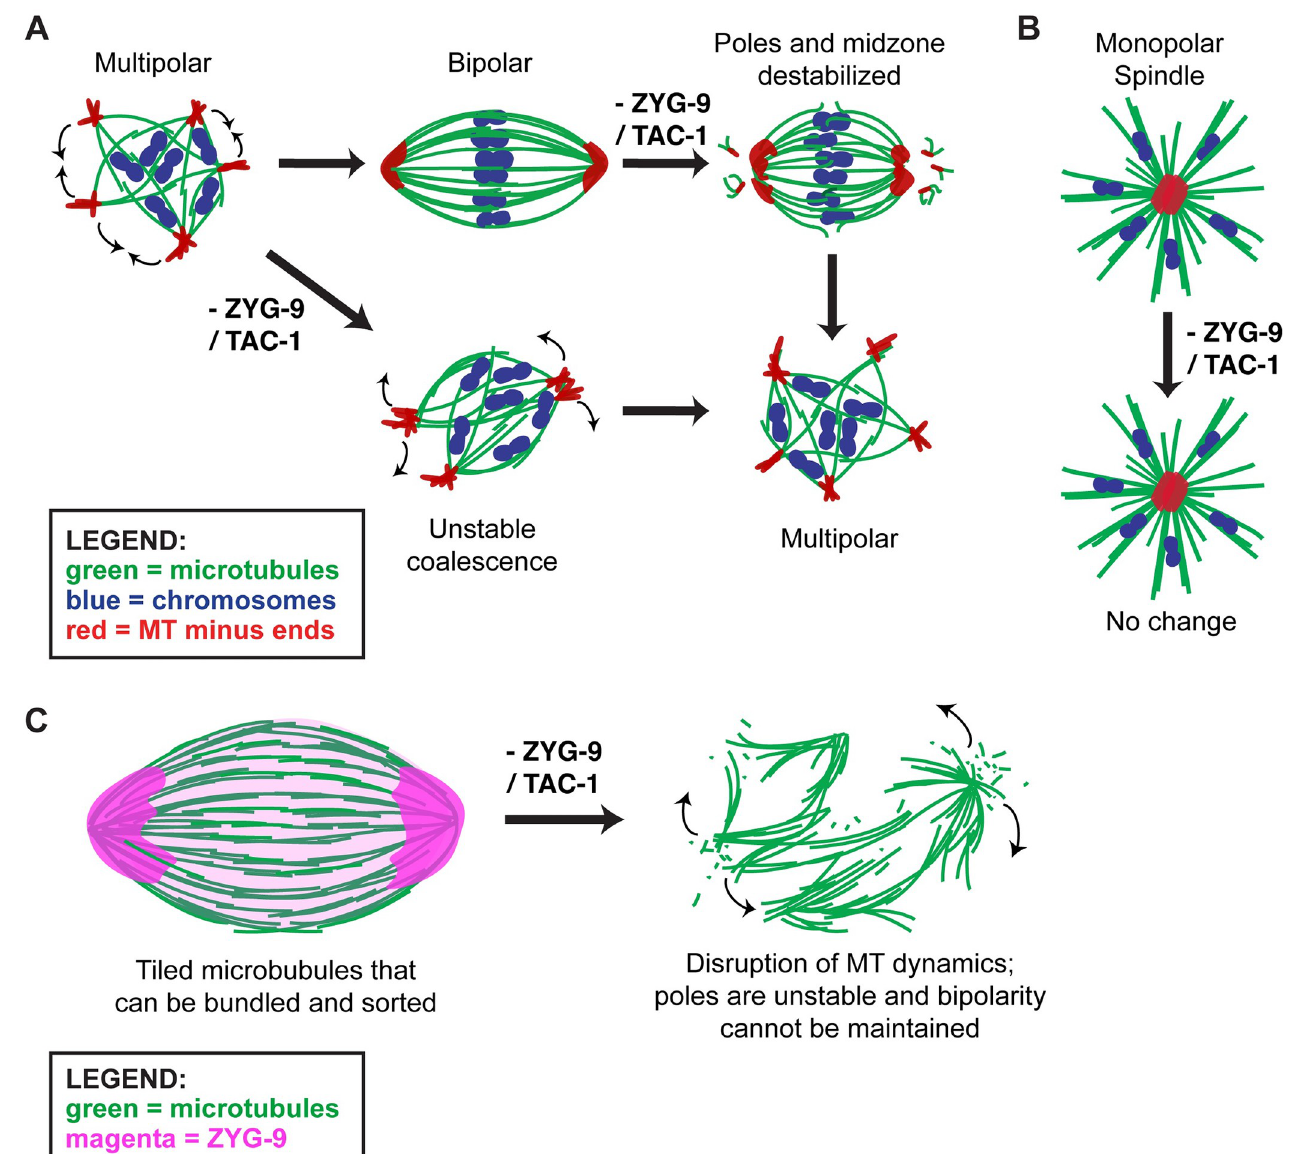
Fig 8. Model of acentrosomal pole coalescence and stability provided by ZYG-9. (A) ZYG-9 is required to establish and maintain acentrosomal pole stability during meiosis. Removal of ZYG-9 prior to spindle assembly prevents multipolar spindles from stably coalescing into bipolar spindles. Additionally, removing ZYG-9 from stable bipolar spindles causes splaying of microtubule bundles near chromosomes and fragmentation of acentrosomal poles, ultimately causing the spindle to lose bipolarity and revert to a multipolar state. (B) Removal of ZYG-9 from a monopolar spindle causes no obvious defects to spindle morphology or monopole stability, suggesting that ZYG-9’s role in spindle bipolarity is not tied directly to acentrosomal poles. (C) Model: ZYG-9 is required for proper microtubule dynamics within the acentrosomal spindle, which is critical for the organization of tiled microtubules into stable bundles via microtubule motors/ MAPs. Removal of ZYG-9 leads to defects in microtubule stabilization, leading to rapid splitting of acentrosomal poles, splaying of midspindle microtubule bundles, and loss of spindle